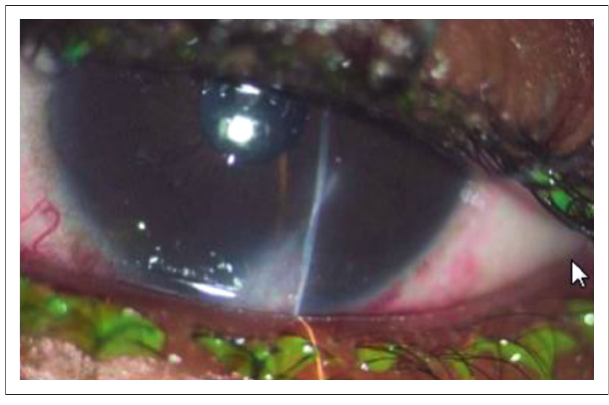
Source : Photo taken by Professor Trevor Carmichael FIGURE 3: Two weeks post operation. Note that suture has been removed. Scarring and deep stromal vascularisation can be